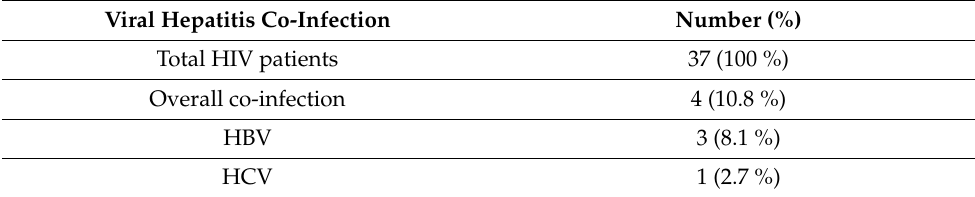
Table 8. Prevalence of HBV and HCV co-infections in HIV-positive patients.